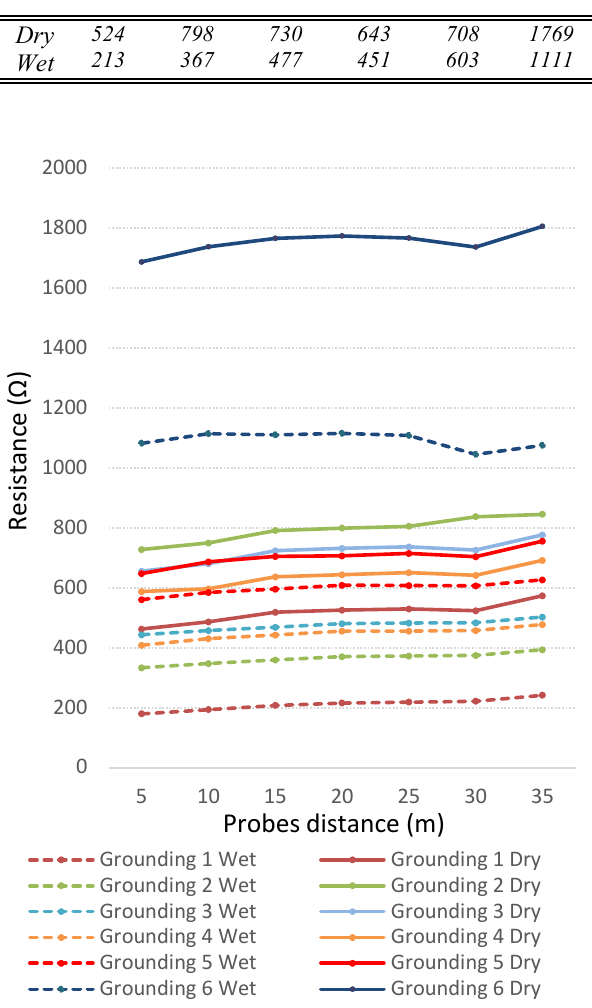
Fig. 10. Grounding Resistance Curves